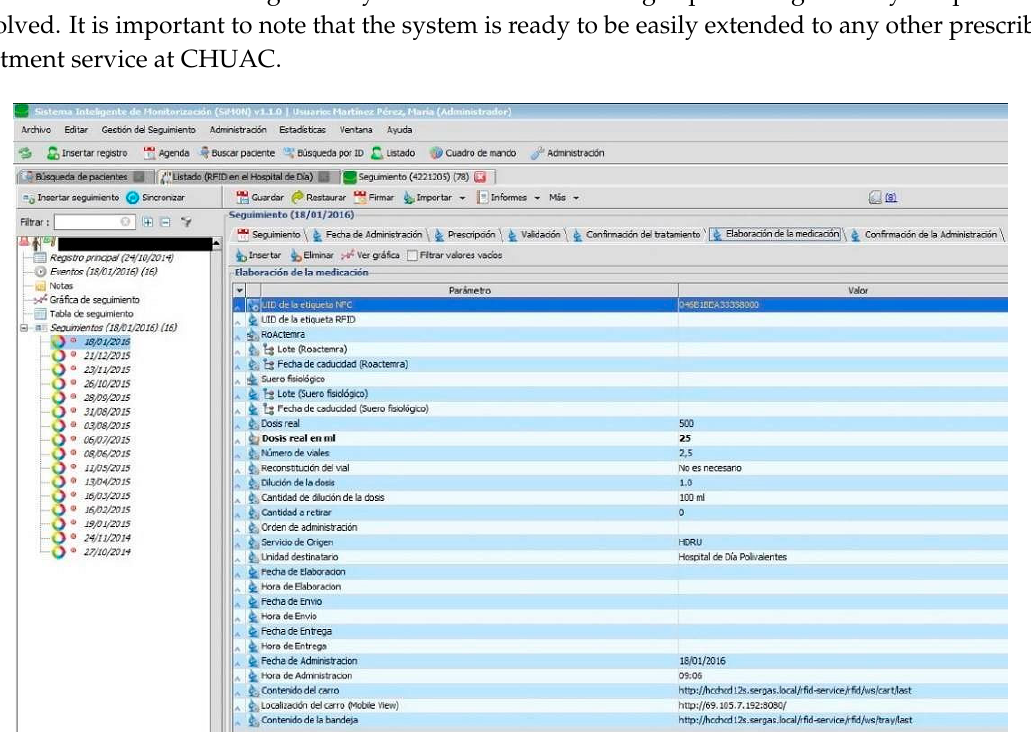
Figure 2. Tracking the preparation of the intravenous mixture.